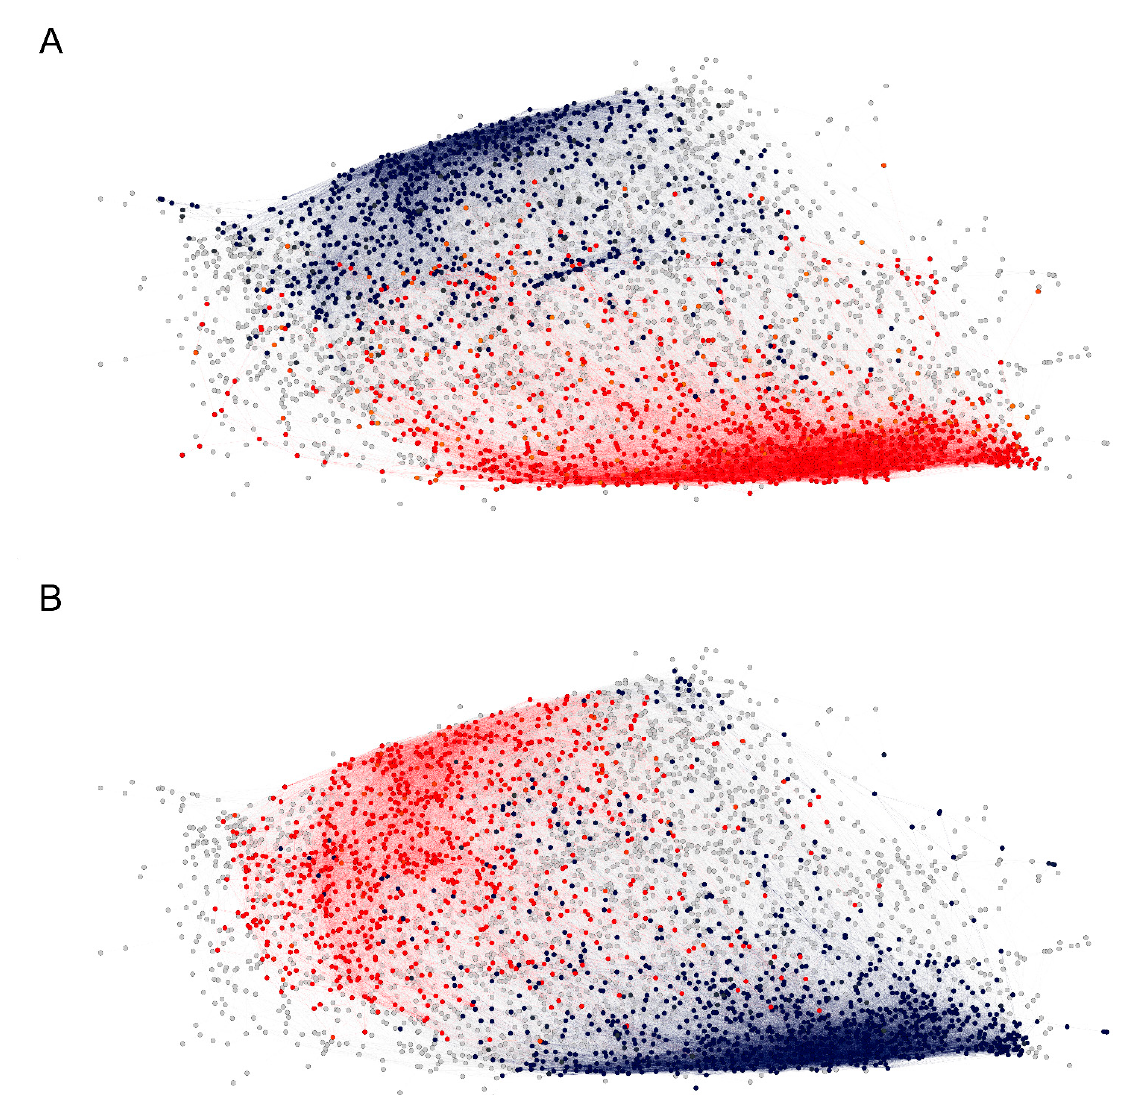
Figure 6. The two dense clusters of reactivity profiles appear to correlate with ABO blood group antigen expression, ( A ) vertices for which the neighborhood-averaged profiles show higher (red) or lower (blue) mean reactivity in patients carrying blood group antigen A. ( B ) The same as ( A ) for patients carrying blood group antigen B.